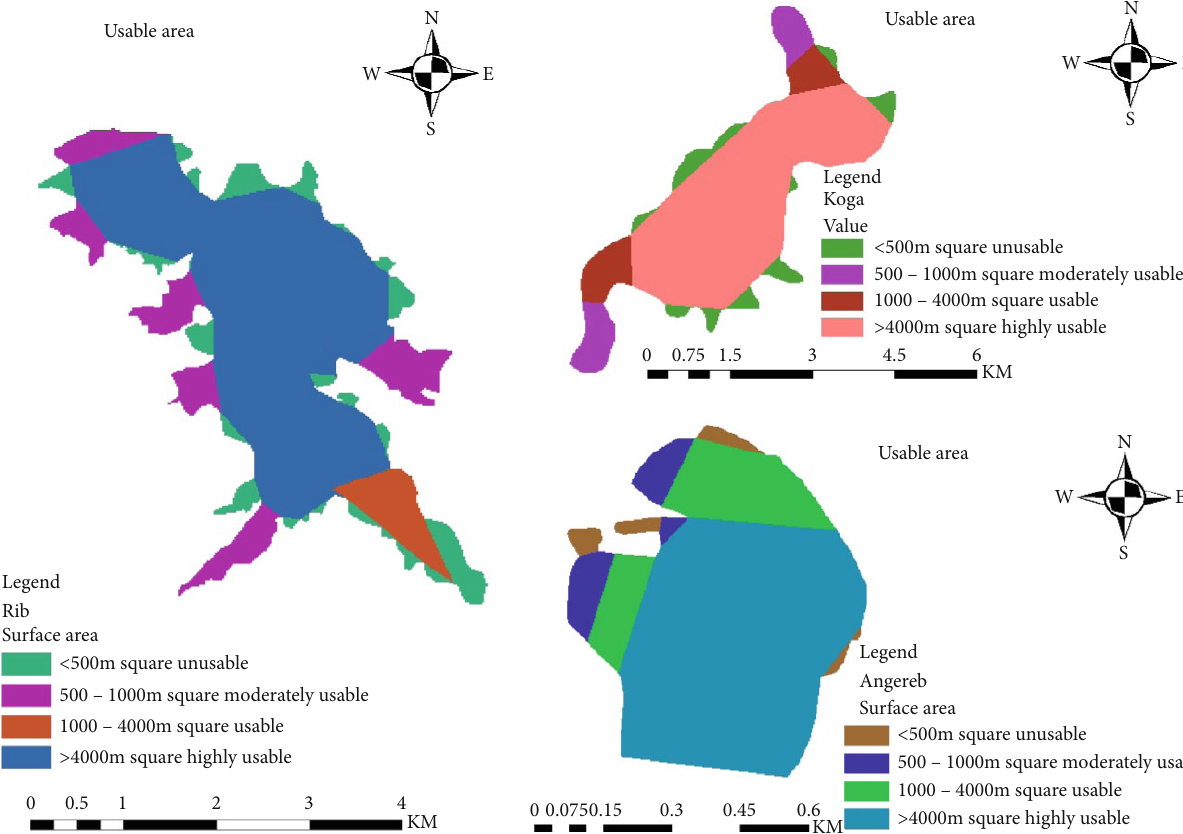
Figure 3: Suitable surface area of water for fl oating solar